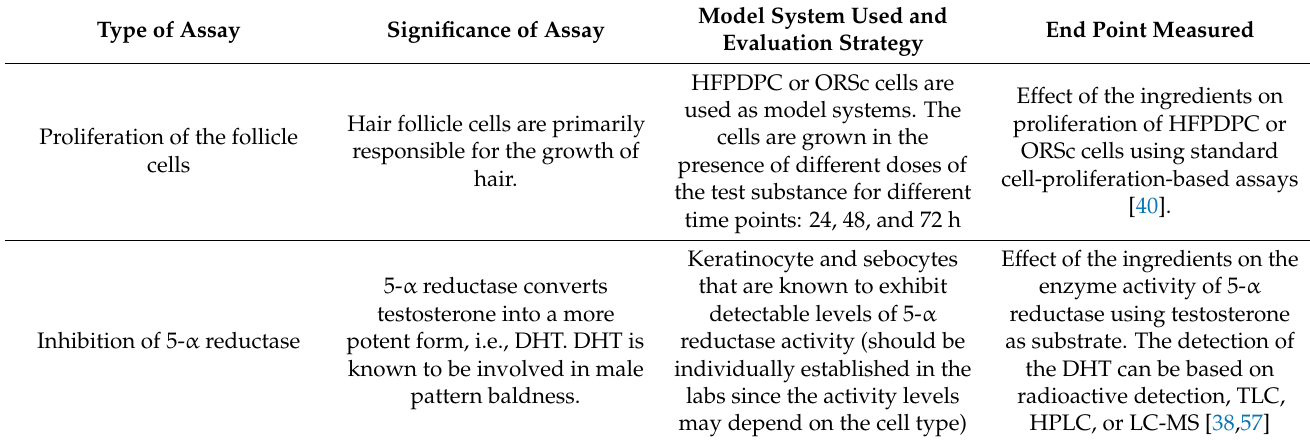
Table 2. Strategies for validation of hair-growth-promoting